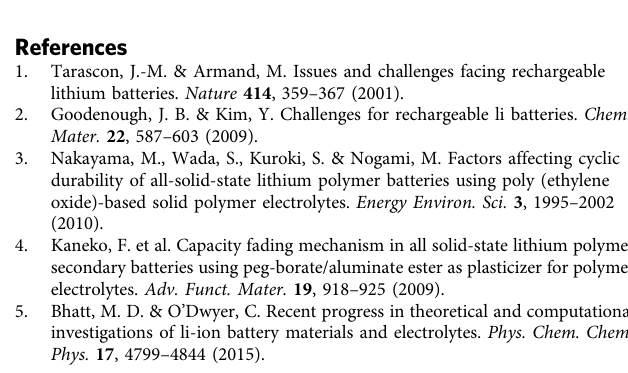
approximation. The basis set for these calculations was aug-cc-PVDZ 66 . For reference, we also compute the IP of the isolated species (anion or solvent in vacuum). The IP shown for the isolated species is the average IP from 50 different con fi gurations taken from MD (created with a single molecule in a cubic box with 100 Å side and using the same force fi eld).